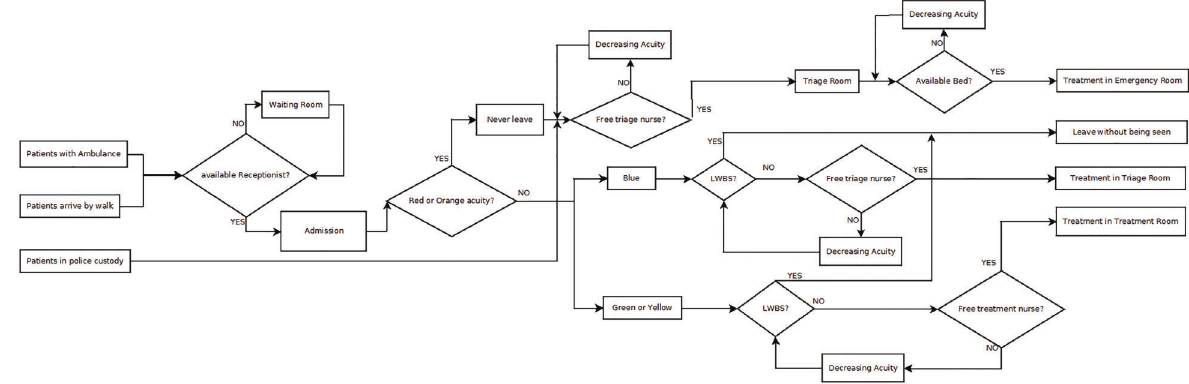
Figure 2. Flow of patients in an emergency department when the patients are categorized based on Manchester Triage System and they can leave without being seen (LWBS).